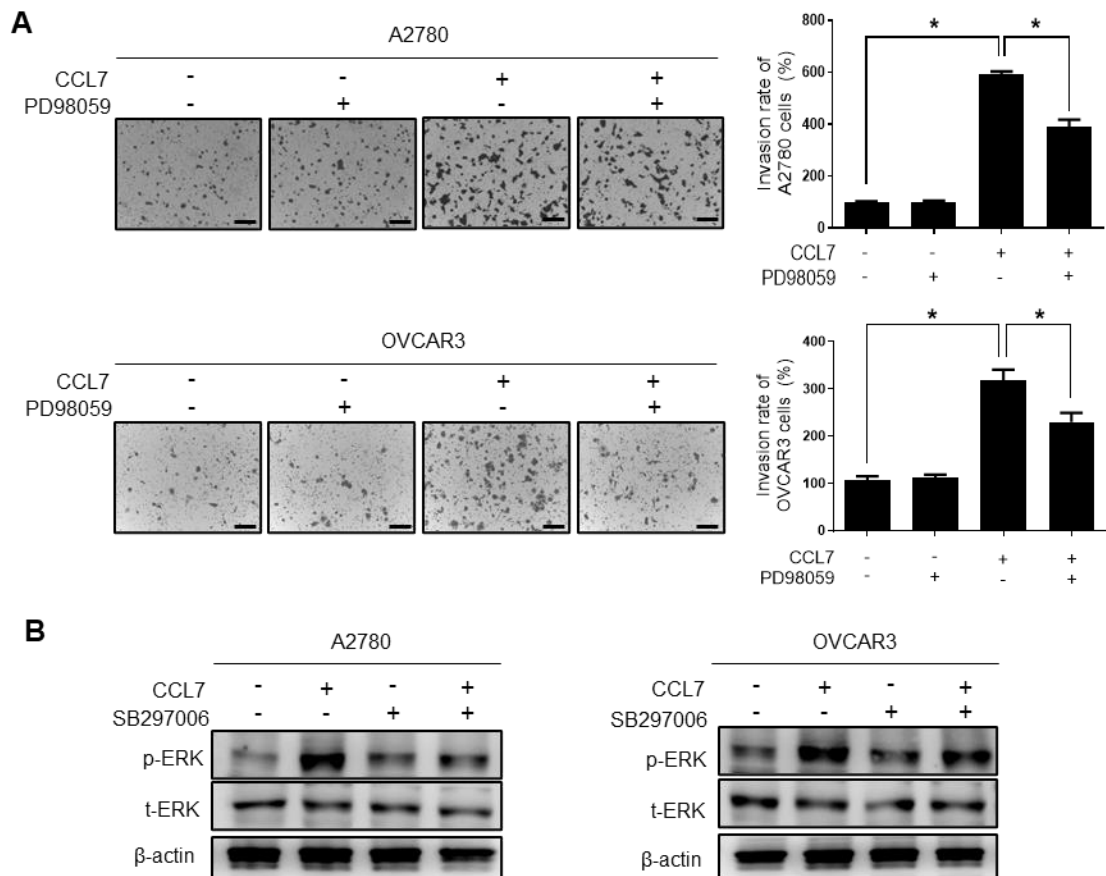
Figure 6. Involvement of extracellular signal-regulated kinase (ERK) signaling in CC chemokine ligand 7 (CCL7)-induced ovarian cancer cell invasion. ( A ) A2780 and OVCAR3 cells were pretreated with the MAPK/ERK Kinase (MEK) inhibitor, PD98059 (70 µM), for 1 h, then treated with recombinant CCL7 (100 ng/mL) for 24 h. The cancer cells were seeded in Matrigel-coated upper chambers and allowed to migrate for 48 h. Scale bar, 100 µm. ( B ) A2780 and OVCAR3 cells were pretreated with the CCR3 inhibitor, SB297006 (20 µM), for 1 h, then with recombinant CCL7 (100 ng/mL) for 24 h. The levels of phosphorylated and total ERK in A2780 and OVCAR3 cells were analyzed by Western blot assays. Original Western Blots shown in Figure S6. * p < 0.05.